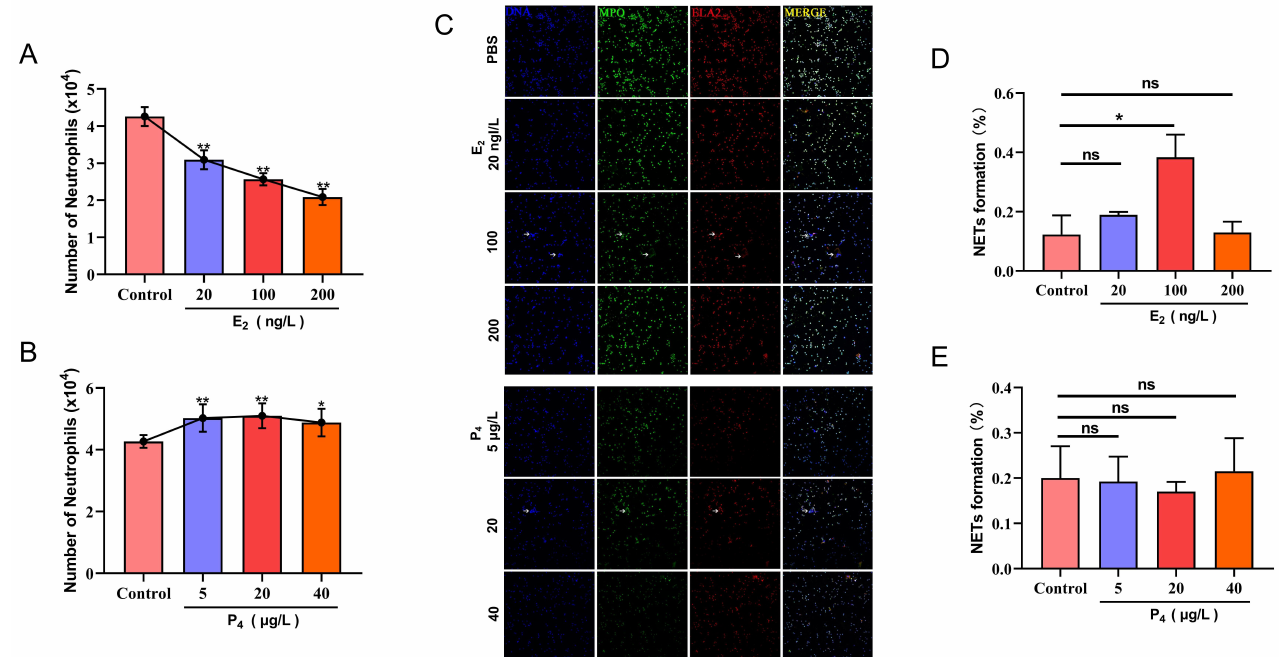
Figure 1. Effects of E 2 and P 4 on migration and NET formation of PMN. ( A ) Effects of E 2 on migration of PMN; ( B ) effects of P 4 on migration of PMN; ( C ) effects of E 2 and P 4 on NET formation of PMN (white arrows: NET); ( D ) effects of E 2 on the percentage of NET formation; ( E ) effects of P 4 on the percentage of NET formation. Data are shown with means ± SD ( n = 3). * p < 0.05, ** p < 0.01, compared to control